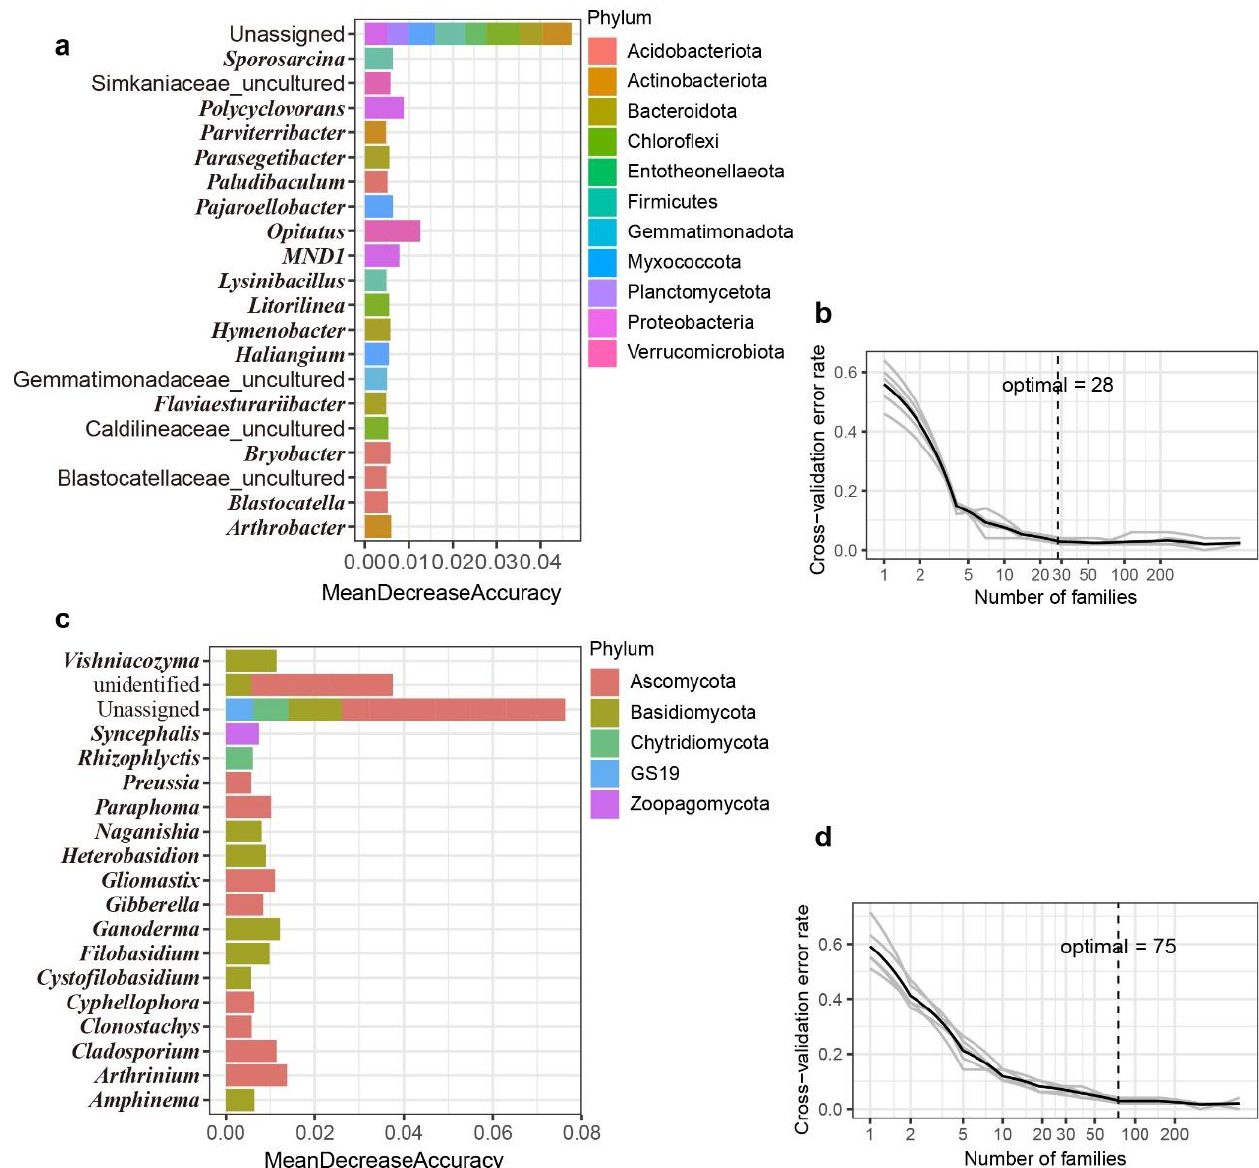
Figure 5. Random forest models for bacterial and fungal communities built at the generic levels show the lowest classification errors. ( a ) Twenty-eight bacterial biomarkers were selected by random forest classification and relative abundance, and ( c ) seventy-five fungal biomarkers were selected by random forest classification and relative abundance. The bar plot of each taxon indicates the taxa’s importance to the model accuracy. The ten-fold cross-validation error and identified number of ( b ) bacterial ( b , d ) fungal biomarkers were used to differentiate hull-less barley from different geographical